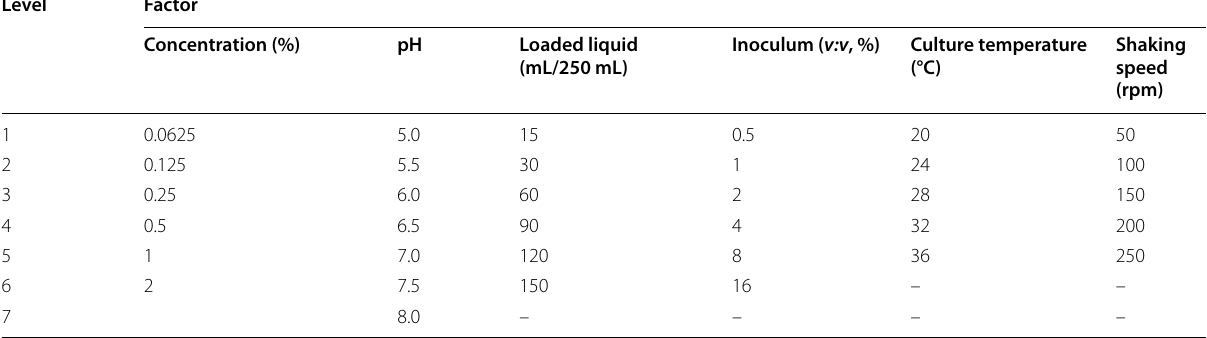
Table 1 Factors and levels assessed in single-factor tests